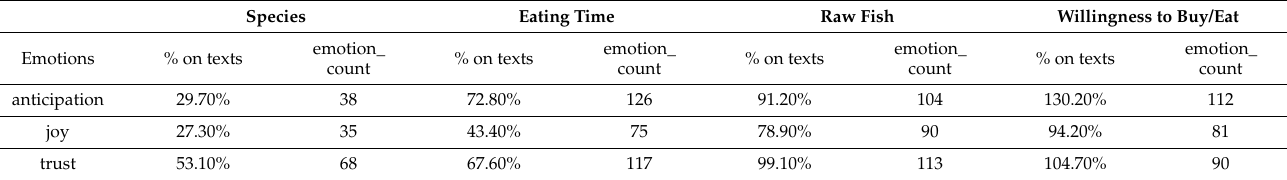
Table 8. Theme 3 Main emotion results with % value and absolute value_ALL